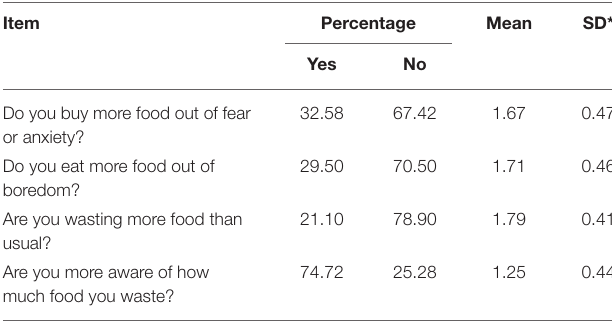
TABLE 5 | Changes in food behavior during the COVID-19 pandemic ( n =